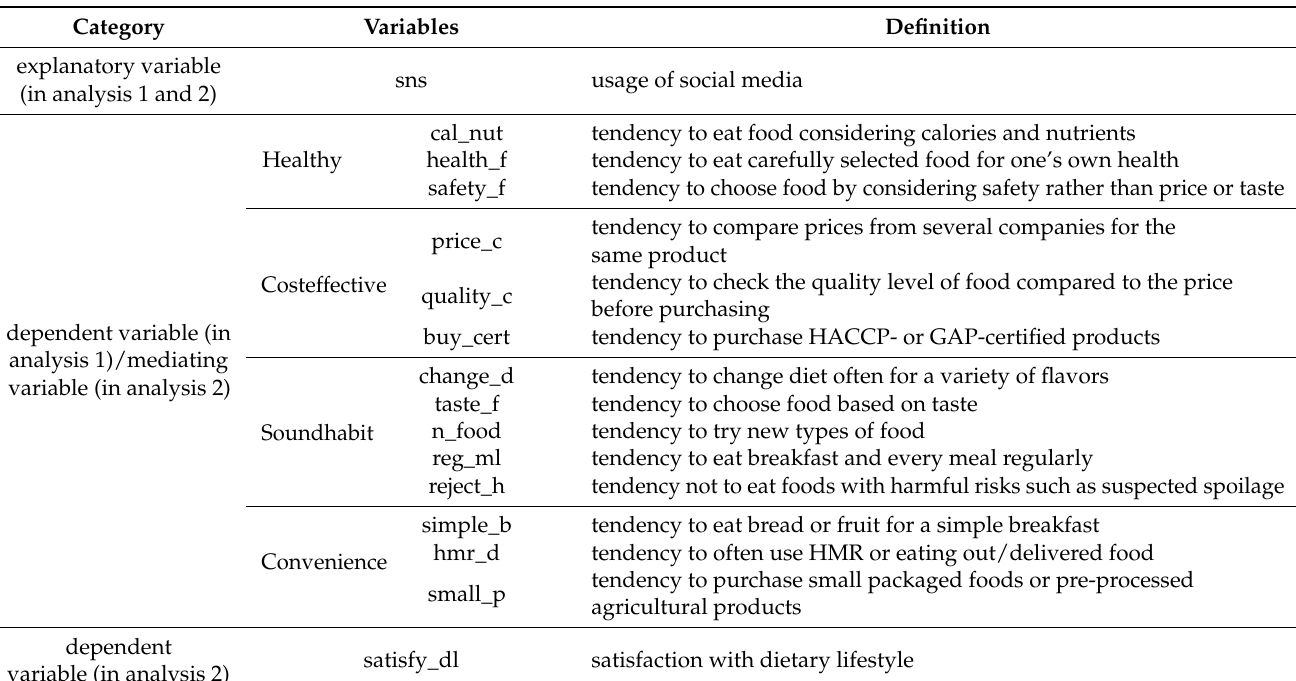
Table 1. Operational definition of variables.